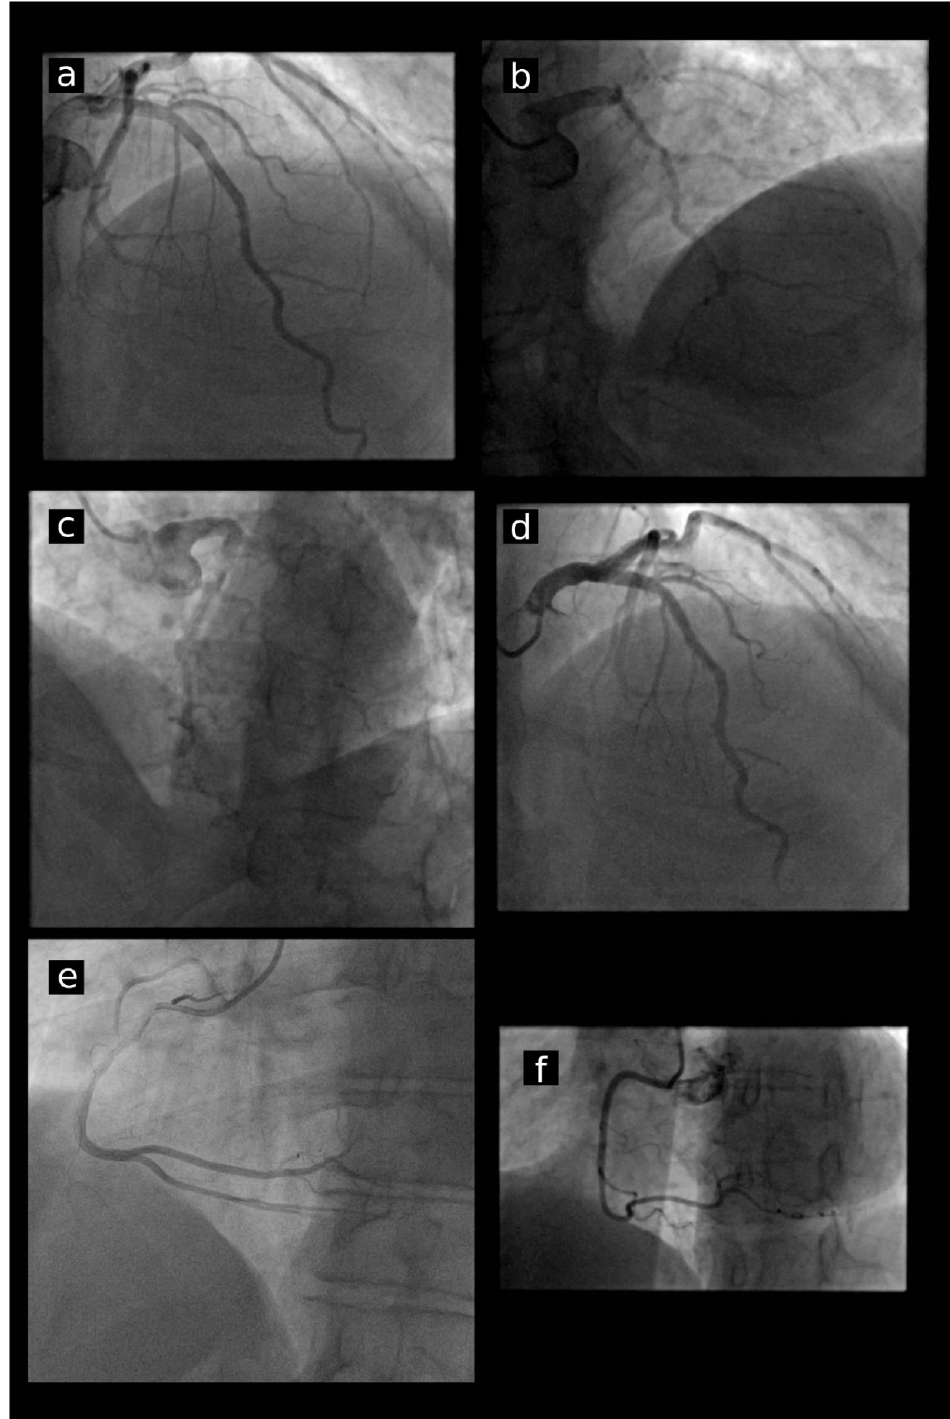
Figure 4. Examples of ostial stability among investigated catheters. ( a – c ) Instability and fall-out of investigated catheters during LCA cannulation. ( d ) Optimal stability of Ultra catheter during contrast injection to LCA, ( e ) unintentional deep intubation of RCA with Transformer catheter, ( f ) poor stability of Trapease catheter during RCA angiography. LCA — left coronary artery; RCA — right coronary artery